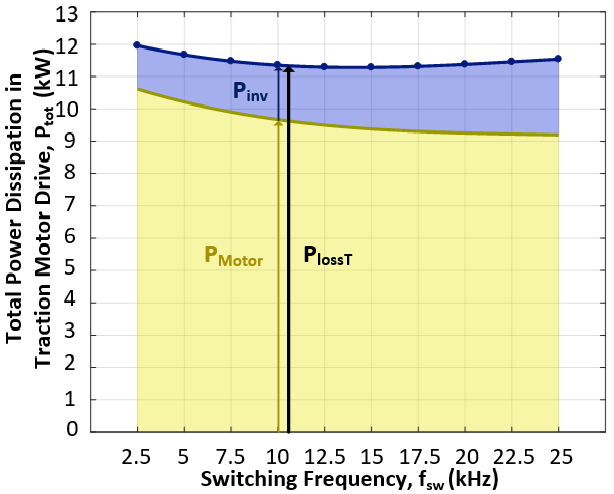
Figure 13. Total power loss of the traction motor drive, P tot , against switching frequency, f sw , when V dc = 750 V, V s = 480 V l-to-l, f s = 60 Hz, and n r = 1779 rpm in delivering 125 kW to its load.